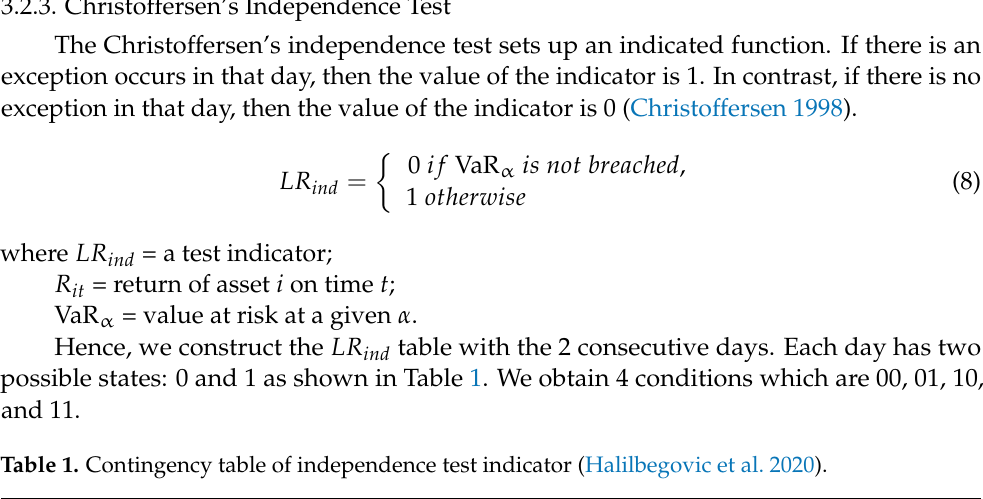
Table 1. Contingency table of independence test indicator (Halilbegovic et al. 2020). Indicator Test